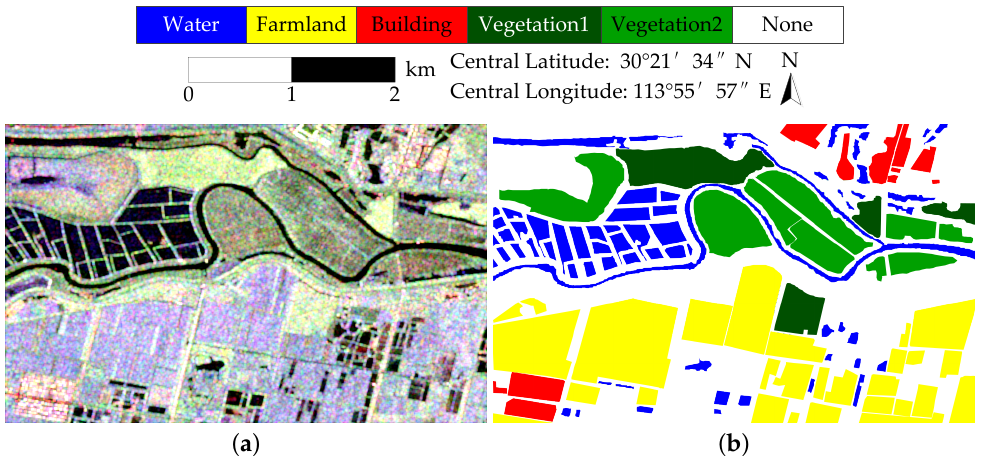
Figure 5. GF-3 Wuhan dataset and the ground truth map. ( a ) Pauli pseudo-color image of GF-3 Wuhan; ( b ) Ground truth map of GF-3